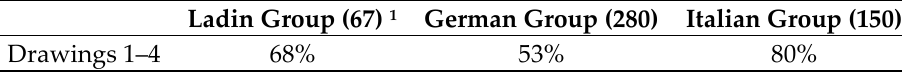
Table 11. Group comparison of the climb percentage in drawings 1, 2, 3, and